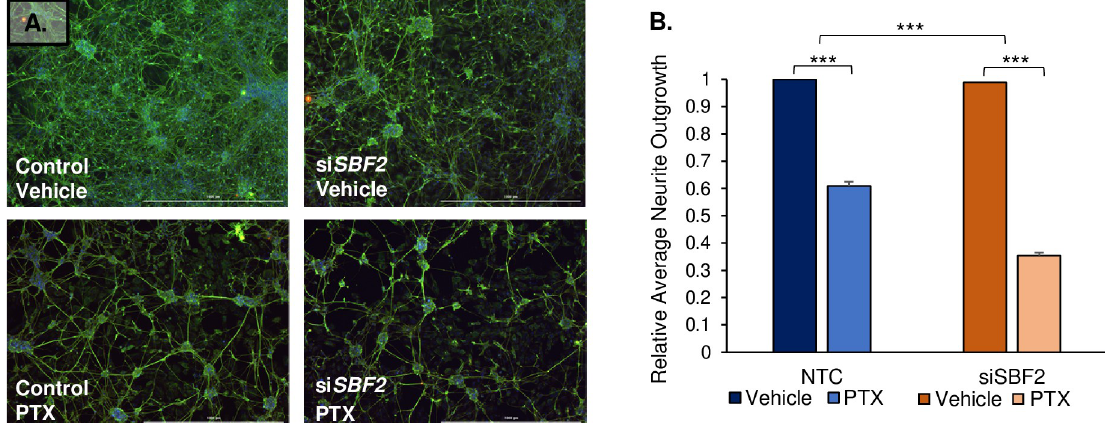
Fig 3. Silencing SBF2 in iPSC-dSN exacerbates paclitaxel-induced morphology phenotype. A) Representative images of neurite outgrowth. Neurite outgrowths are stained by β III-tubulin (green) and cell nuclei are stained with Hoeschst 33342 dye (blue). Scale bars = 1000 μ m. B) Average neurite outgrowth of paclitaxel-treated NTC and si SBF2 cells relative to baseline (vehicle-treated cells) for visualization. The graph represents all six cell lines compiled and performed in triplicates. (NTC = non-targeted control, PTX = paclitaxel, �� = p < 0.01, ��� = p < 0.001). Error bars represent